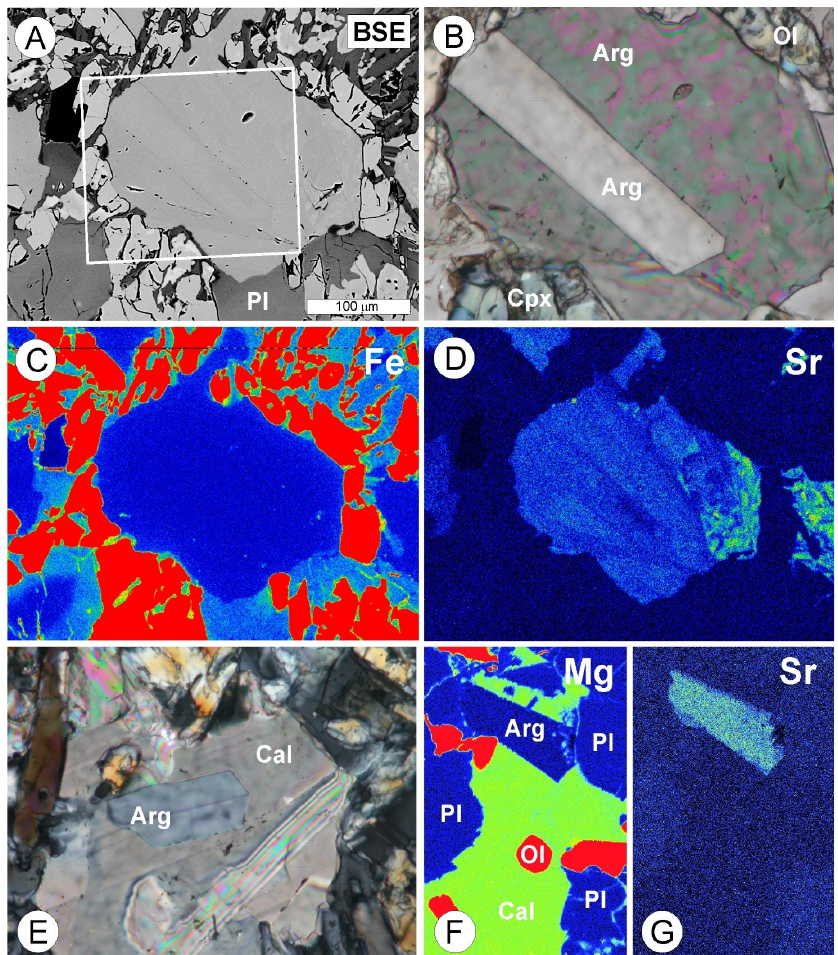
Figure 12. X-ray maps, transmitted light, and BSE images of carbonates in mafic layers in sample Cam-13: ( A ) BSE image of carbonate pocket showing blocky mosaic texture and one elongated crystal transversal to the square field; ( B ) Partly cross-polarized, transmitted light image of the square field in ( A ), showing euhedral aragonite in aragonite crystal aggregate with variegated interference colors; ( C ) False color-coded X-ray map of iron in ( A ), showing diffusion gradients of iron in plagioclase touching the carbonate pocket and olivine crystals growing at the expense of clinopyroxene in the carbonate; ( D ) False color-coded X-ray map of Sr distribution, showing increased Sr contents in aragonite crystal and local Sr-rich domains in the aragonite matrix; ( E ) Cross-polarized, transmitted light image of aragonite twin in calcite matrix; ( F , G ) False color-coded X-ray map of Mg and Sr distribution showing Sr-rich, Mg-poor aragonite crystal in Mg-rich, Sr-poor calcite groundmass. Warmer colors in ( C , D , F , G ) denote higher concentrations. Mineral abbreviations [30]: Arg—aragonite, Cal—calcite, Pl—plagioclase, Ol—olivine,